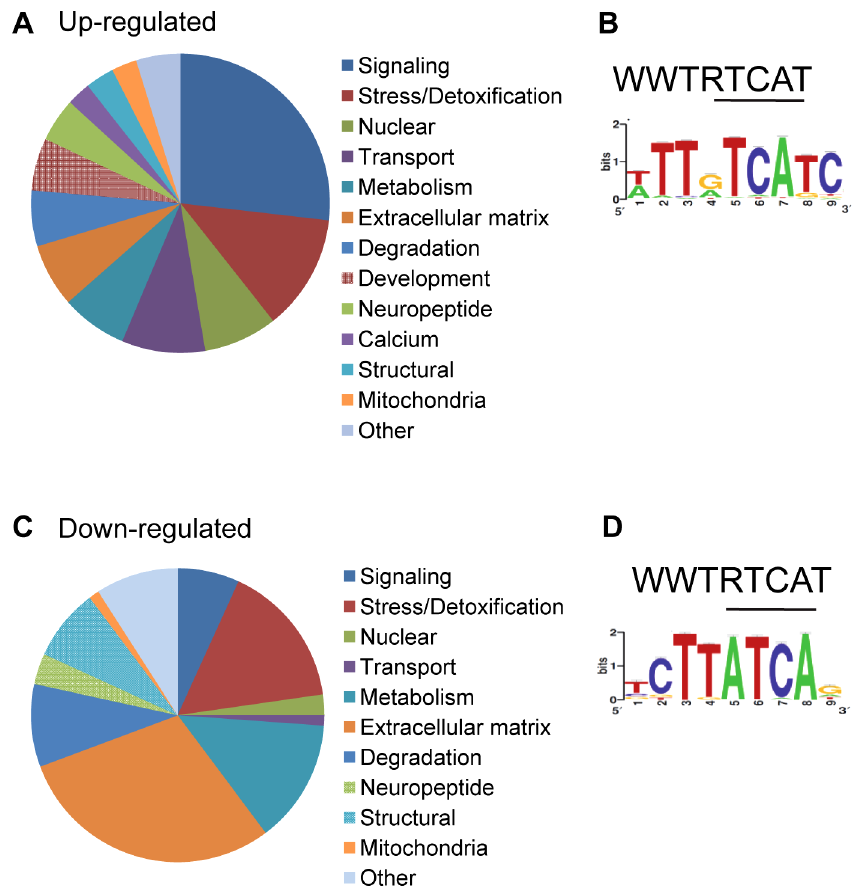
Figure 8. Functional analysis of genes significantly different in wdr-23 mutants. (A–B) Analysis of 2285 up-regulated genes in wdr-23 mutants. (A) Representation of functional groups of up-regulated genes with known function (1316 genes) in wdr-23 mutants relative to wild type classified by GO terms and protein domain established by DAVID analysis. (B) Canonical SKN-1 binding sequence and enrichment of SKN-1 binding motif identified by RSAT oligonucleotide analysis. One kilobase of intergenic sequence upstream of each ORF for all 2285 up-regulated genes was used for RSAT analysis. RSAT consensus represented by WebLogo. (C–D) Analysis of 134 genes down-regulated in wdr-23 mutants. (C) Representation of functional groups of down-regulated genes with known function (88) in wdr-23 mutants relative to wild type. (D) Canonical SKN-1 binding sequence and enrichment of SKN-1 binding motif identified by RSAT oligo analysis.